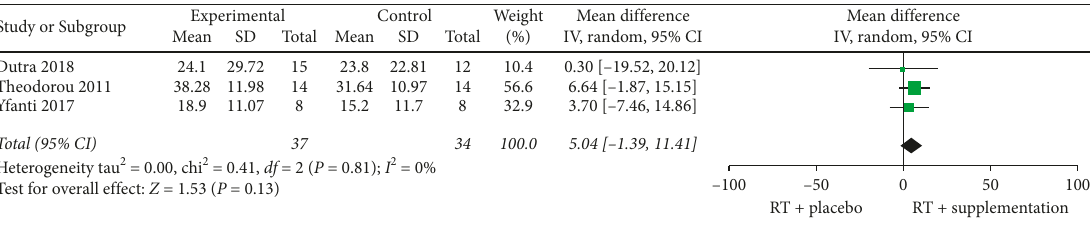
Figure 2: Results of the